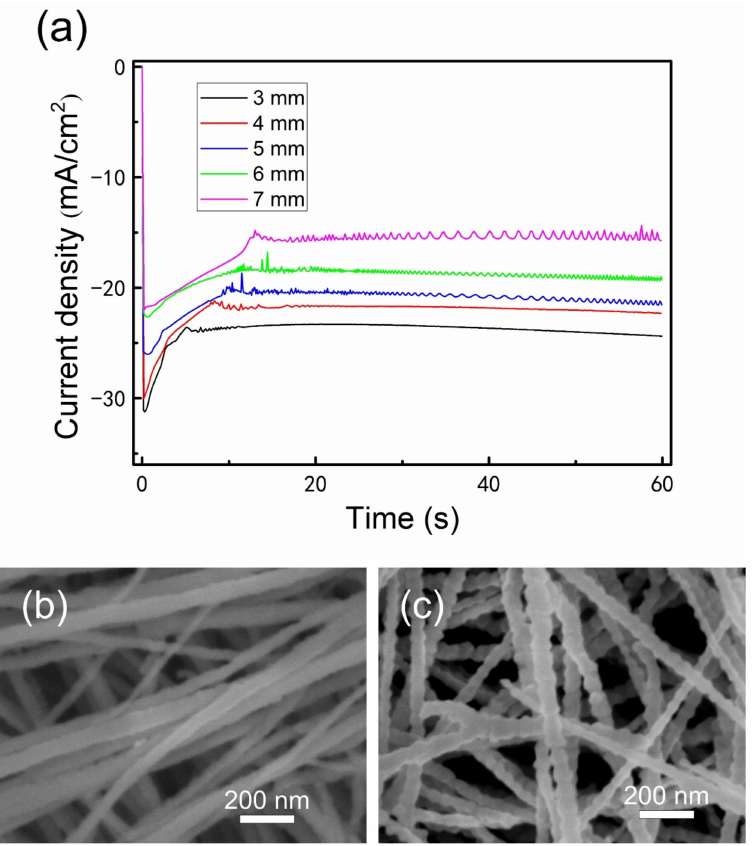
Figure 2. Potentiostatic electrodeposition of Al nanowires in AlCl 3 –BMPC (2:1 molar ratio) ionic liquid at − 1.2 V/25 ◦ C for 60 s under the unrestricted diffusion condition: ( a ) the chronoamperometry curves recorded on various sized Cu plates (the side lengths of squares are marked in the graph) during the electrodeposition, and SEM images of the deposits on the marginal part ( b ) and the central part ( c ) of the 7 × 7 mm–sized Cu